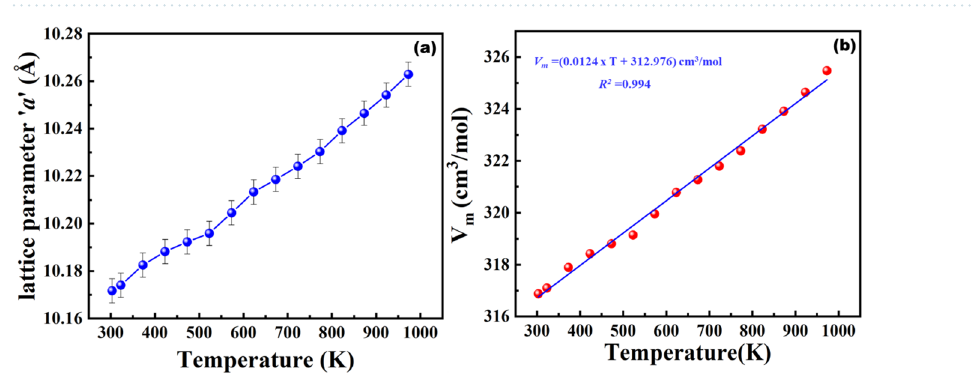
Figure 7. ( a ) The lattice parameter ‘ a ’ as a function of temperature ( b ) molar volume ( V m ) of BFO as a function of